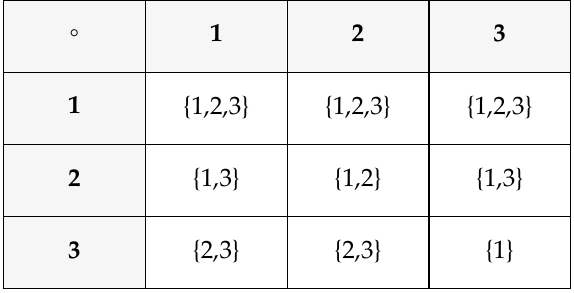
Table 7. Transposition left almost-hypergroup.